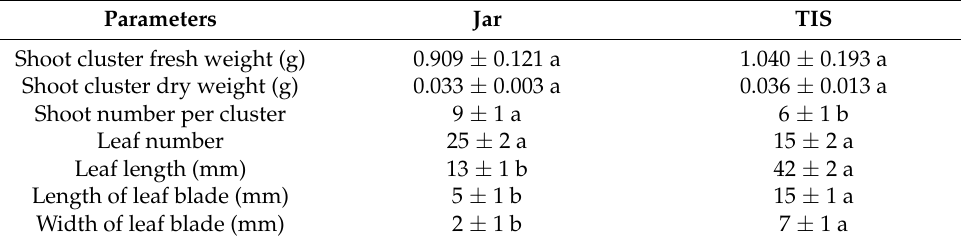
Figure 2. M. maritima shoot clusters from the jars (left) and Plantform (right) after 4 weeks of culture. Table 1. Shoot micropropagation: comparison between solid (jar) and temporary immersion system (TIS—Plantform) culture